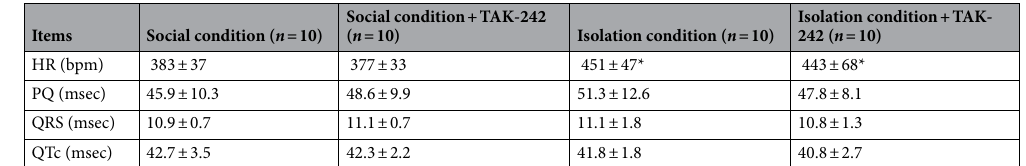
Table 3. ECG results of normal and socially isolated animals. HR heart rate, bpm beats per minute, msec millisecond. * P < 0.05 compared to social conditioned animals.